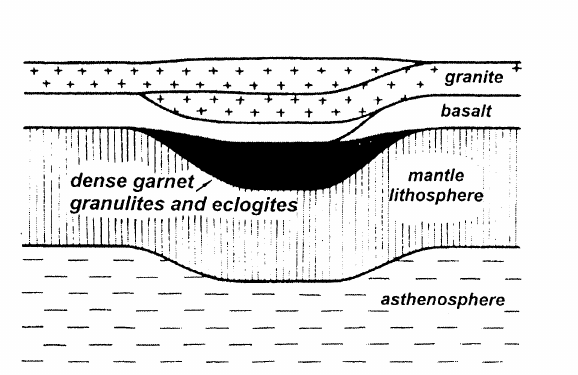
FIGURE 6 Formation of garnet granulites and eclogites in the lower crust at the epochs of strong compression of the lithosphere with thickening of the crust in fold belts. These dense rocks maintain the surface of a thickened crust at a low